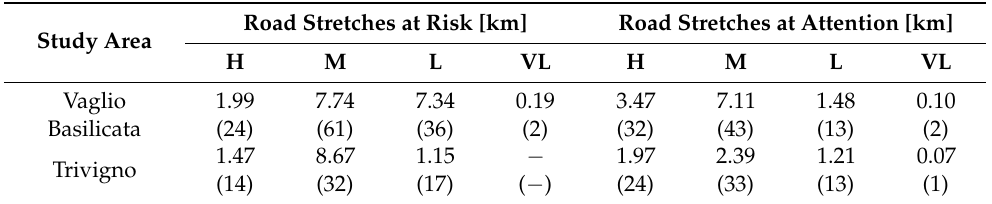
Table 7. Total lengths of road stretches classified at high (H), medium (M), low (L) and very low (VL) risk (or attention) in Vaglio Basilicata and Trivigno. The number of road stretches are reported in